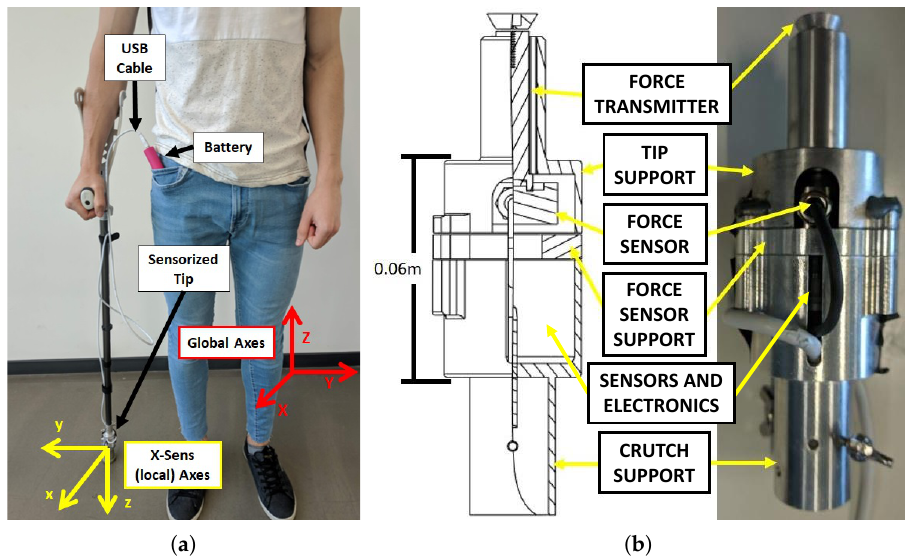
Figure 1. ( a ) System elements and reference axes. ( b ) Sensorized Tip mechanical